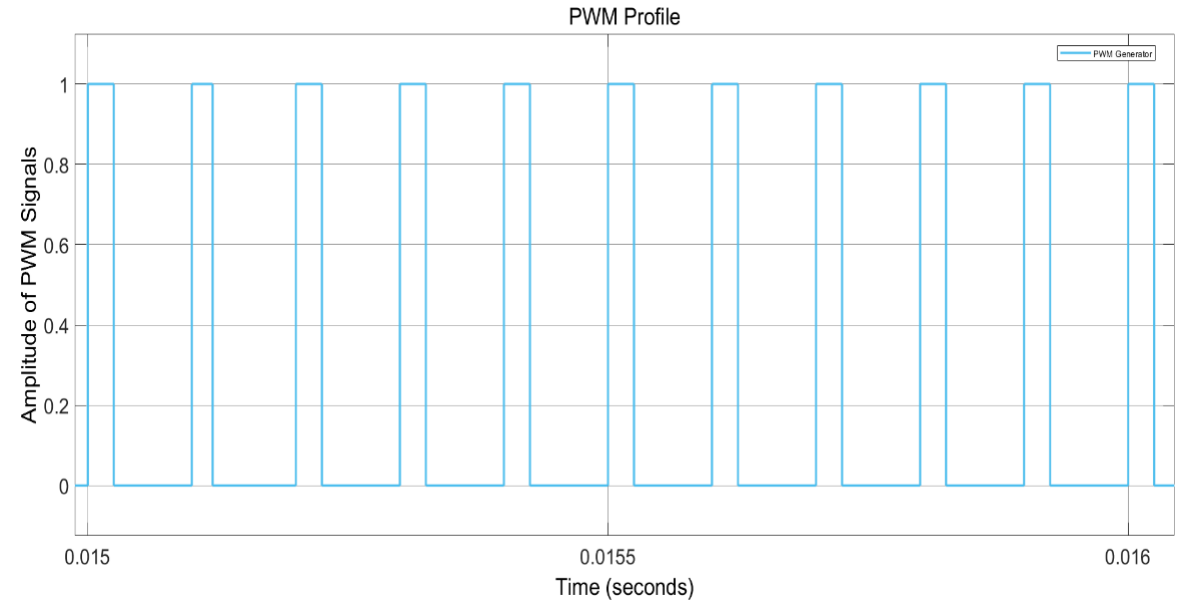
Figure 10. Output current profile.